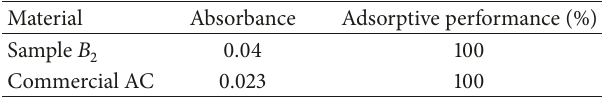
Table7:Adsorptiveperformanceandabsorbanceofthesynthesized and commercial activated carbons.